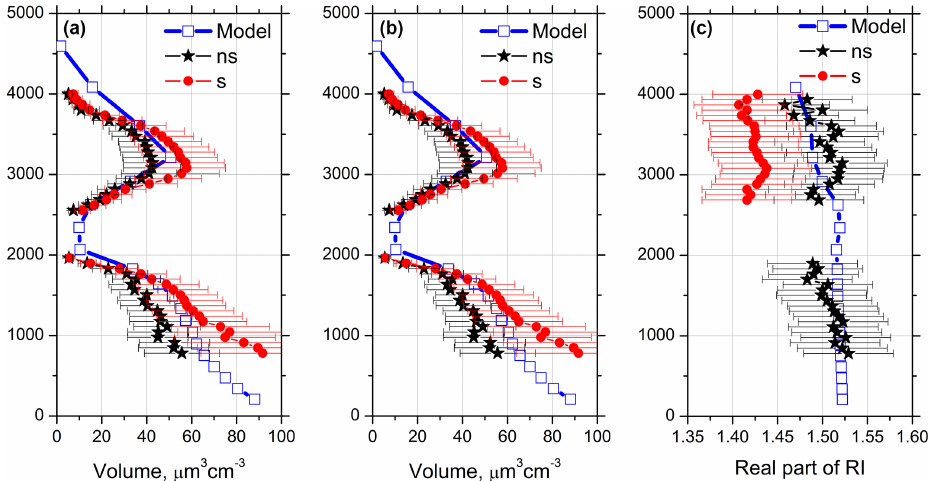
Figure 18. Profiles of (a) effective radius, (b) particle volume, and (c) real part of the refractive index on 24 December 2015 retrieved from 3 β + 2 α lidar measurements shown in Fig. 7a (solid symbols) and provided by MERRA-2 for 21:00UTC (open symbols). Inversion of lidar measurements was performed in assumption of spherical particles (s) and using the model of spheroids (ns).